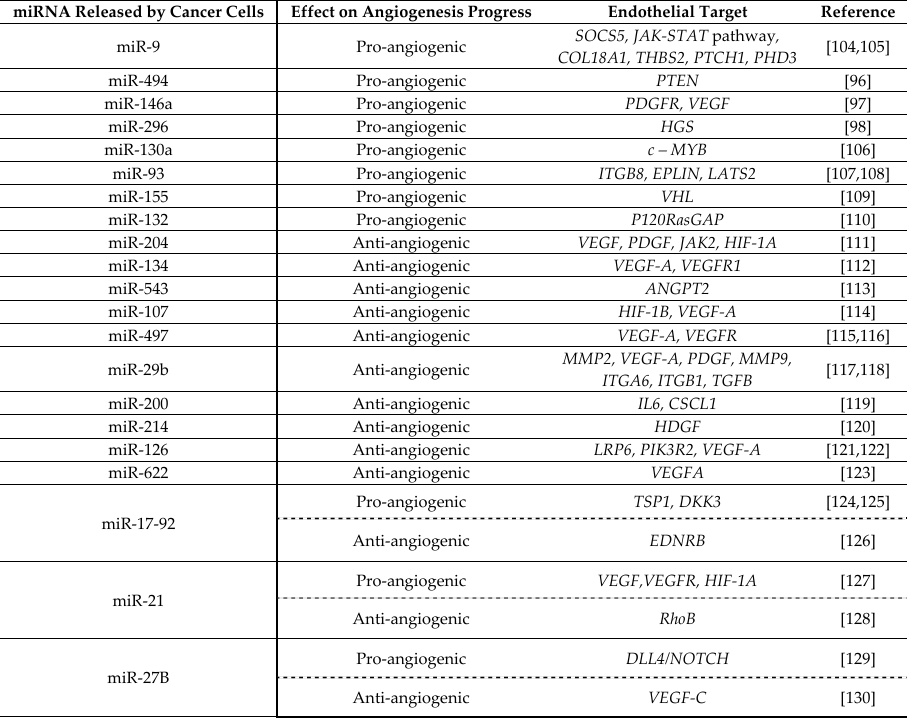
Table 2. miRNAs regulating cancer—TECs cross-talk. Int. J. Mol. Sci. 2020 , 21 , x FOR PEER REVIEW 10 of